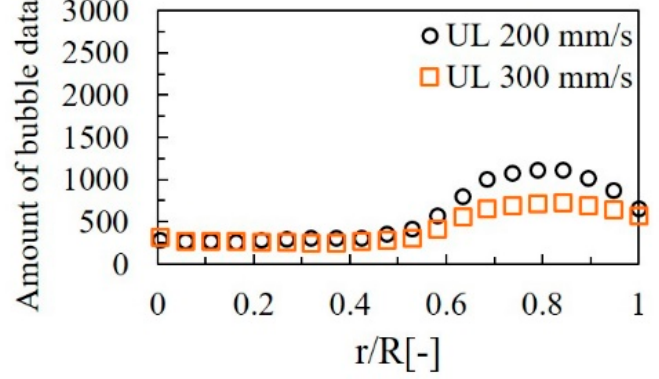
Figure 16. Amount of bubble data.